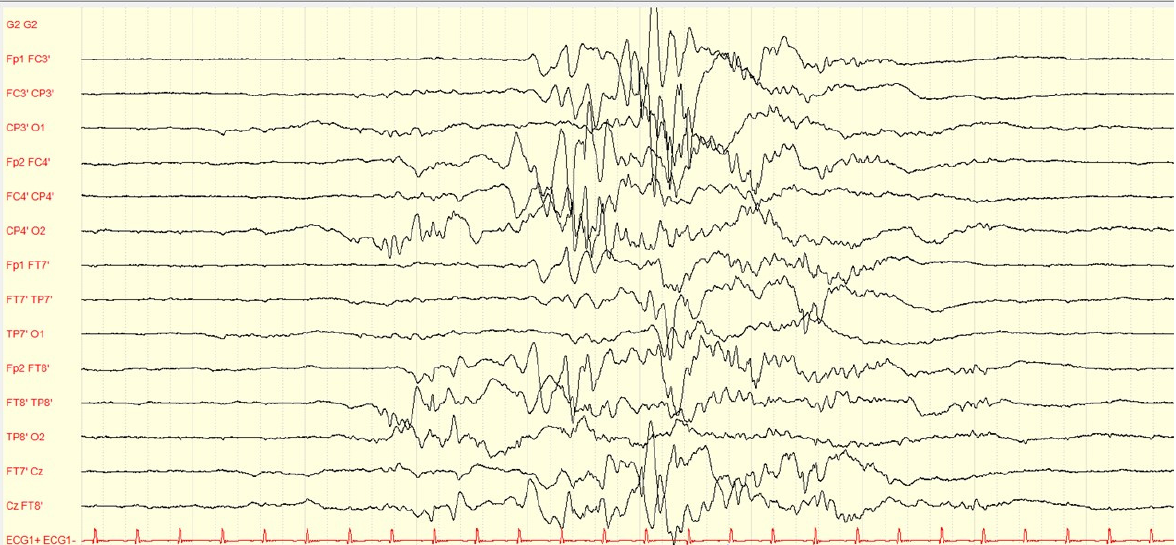
Figure 2. Burst suppression EEG trace of a neonate with PNPO de fi ciency who was born at 37 weeks gestational age and presented with status epilepticus on the fi rst day of life. The neonate was treated fi rst with 40 mg/kg levetiracetam and then with 5 mg/kg phenobarbital with only partial response. Next, according to our institutional protocol, we administered pyridoxine 100 mg i.v., followed by a maintenance dosage of 30 mg/kg/day. The introduction of pyridoxin led to seizure freedom and EEG improvement. Highpass: 0.530 Hz, Lowpass: 70 Hz.